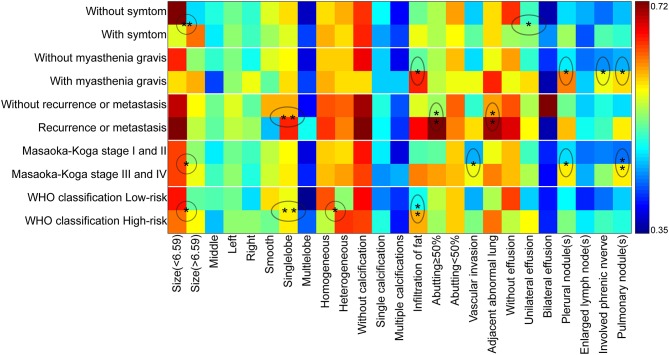
The schematic diagram of CT imaging features as risk factors for clinical characteristics, Masaoka–Koga stage, and WHO histological classification. The X-axis displayed the CT imaging features and Y-axis indicated the clinical characteristics, Masaoka–Koga stage, and WHO histological classification. The ratio of occurrence frequency of one imaging feature was quantitatively calculated in one subgroup and size of ratio value was represented by color bar (With and without relapse or metastasis were based on a total of 89 patients). The circle and oval circle showed the imaging features as risk factors for the related clinical characteristics, Masaoka–Koga stage, and WHO histological classification. The single star (*) indicated the significant difference (P < 0.05) and the double stars (**) indicated the significant difference (P < 0.01) by the binary logistic regression analysis.